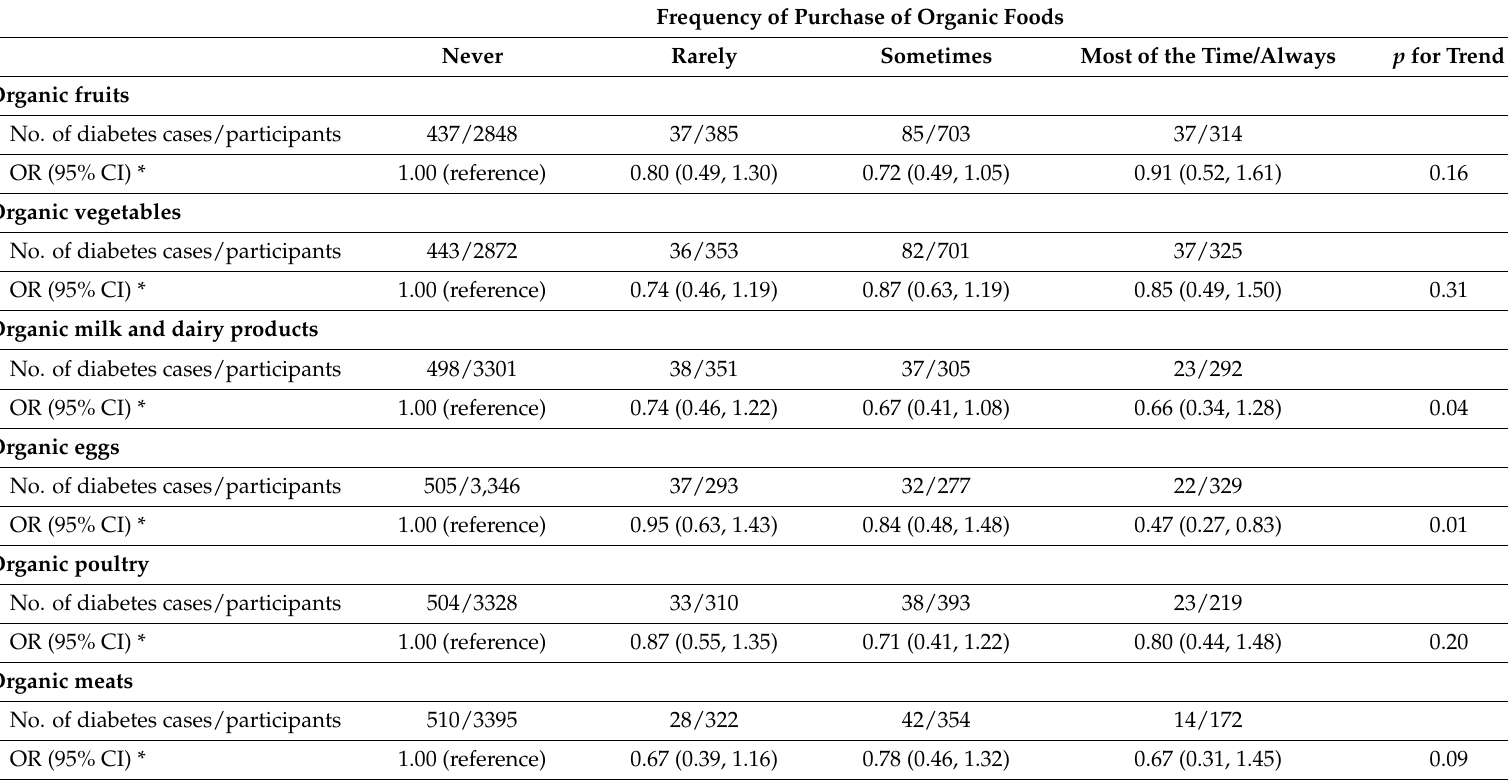
Table 4. Association between the frequency of purchase of different organic foods and diabetes among 4250 participants, NHANES 2009–2010. Frequency of Purchase of Organic Foods Never Rarely Sometimes Most of the Time/Always p for